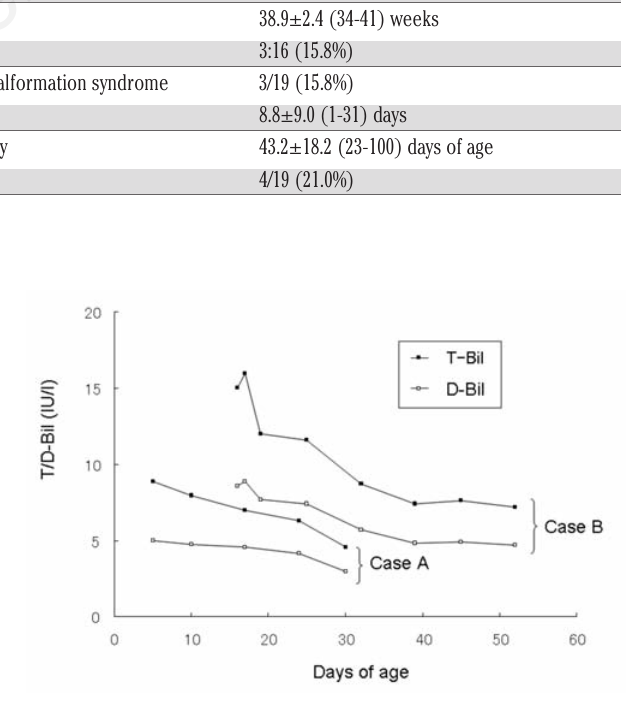
Figure 2. The levels of total bilirubin (T-Bil), direct bilirubin (D- Bil) of 2 cases with BASM who presented extreme decreasing